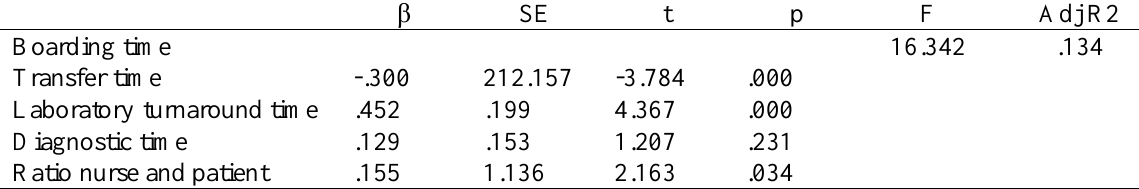
Table 3. Multivariate analysis among the